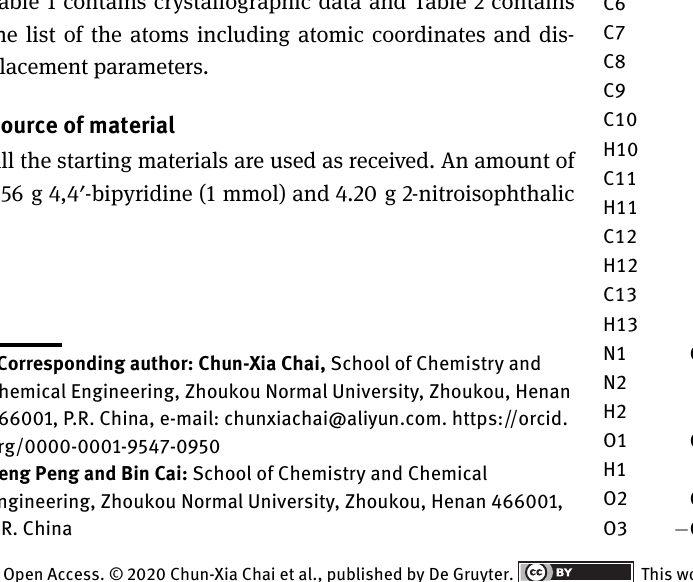
Table 1 contains crystallographic data and Table 2 contains the list of the atoms including atomic coordinates and dis- placement parameters.